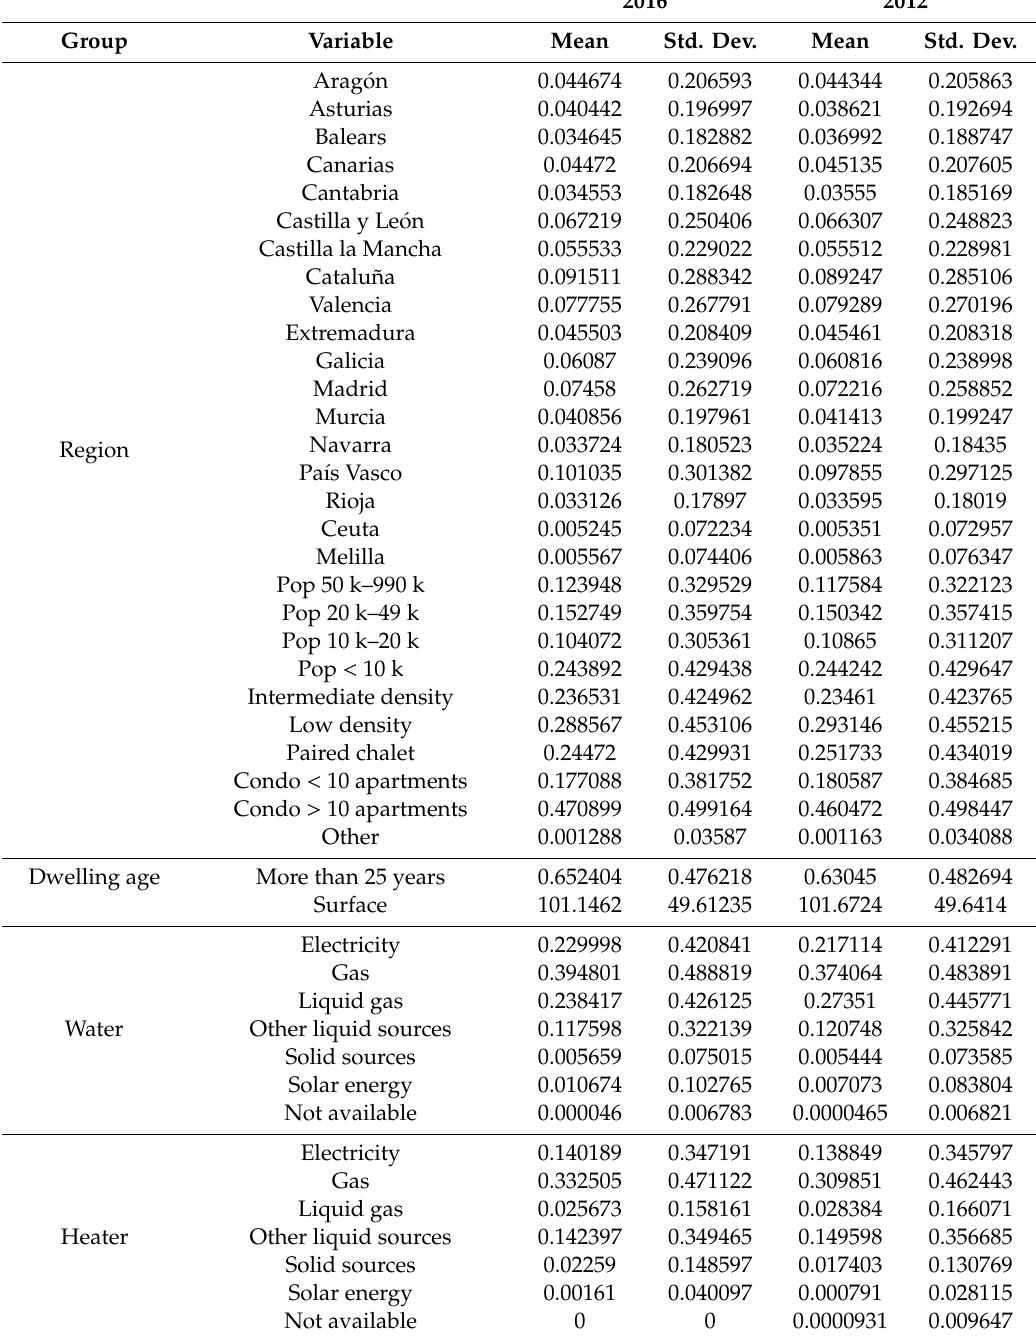
Table A1. Descriptive statistics of the explanatory